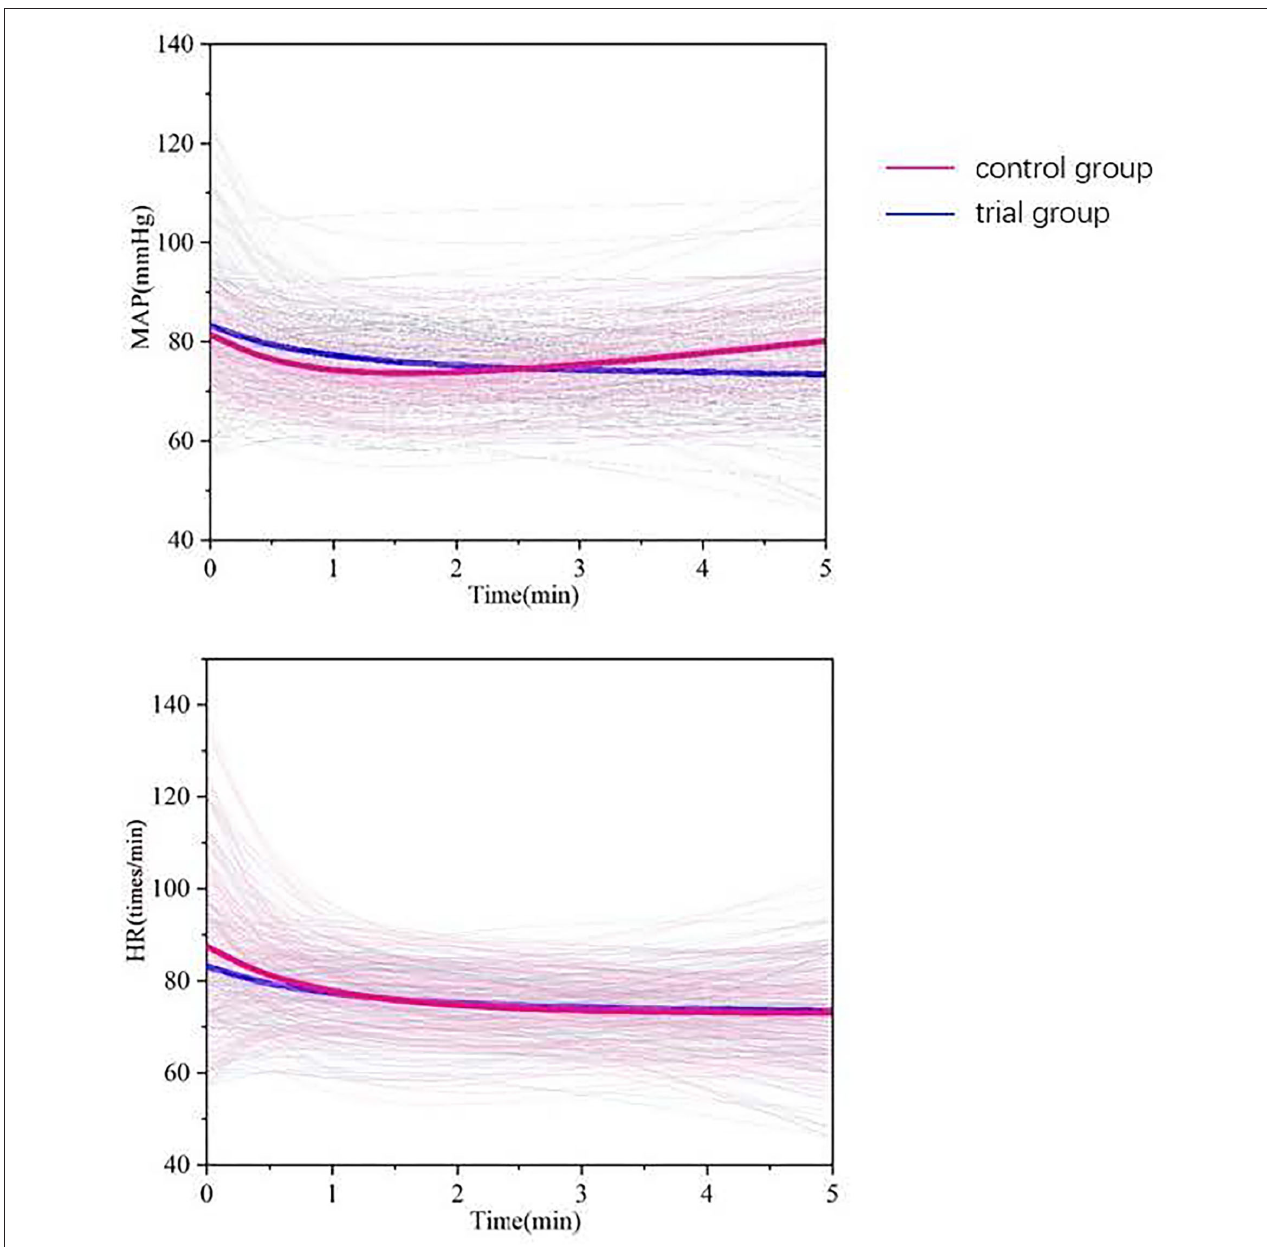
FIGURE 2 | Average values of the hemodynamic variables studied (thick line) and individual patient data (thin line) : the red line represents the control group, and the blue line represents the trial